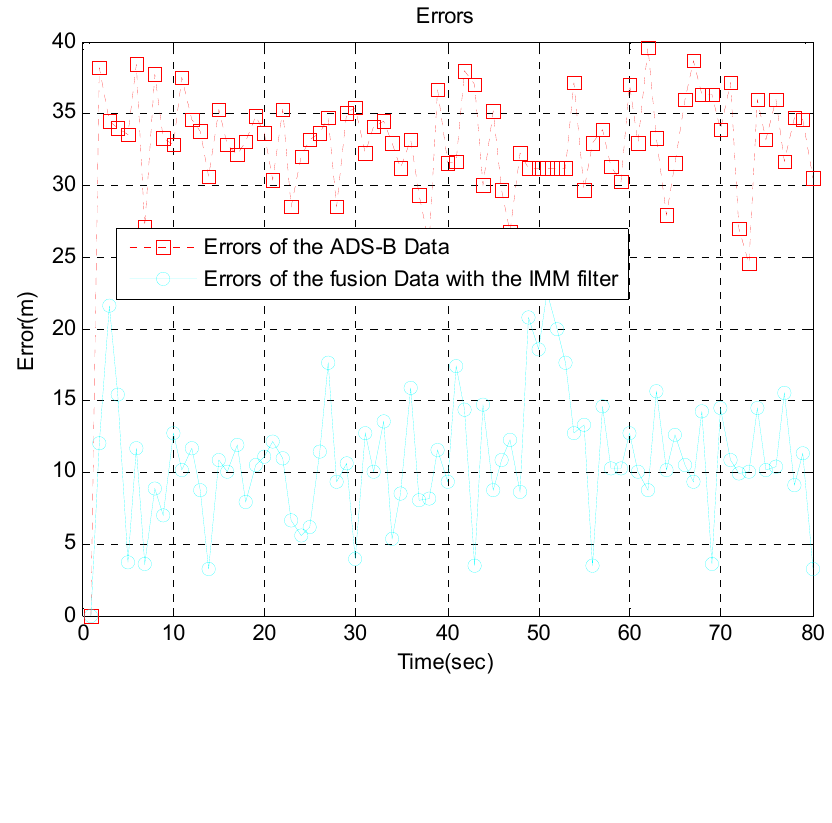
Figure 8. Errors between ADS-B data and fusion data with the IMM filter at 16 km from the